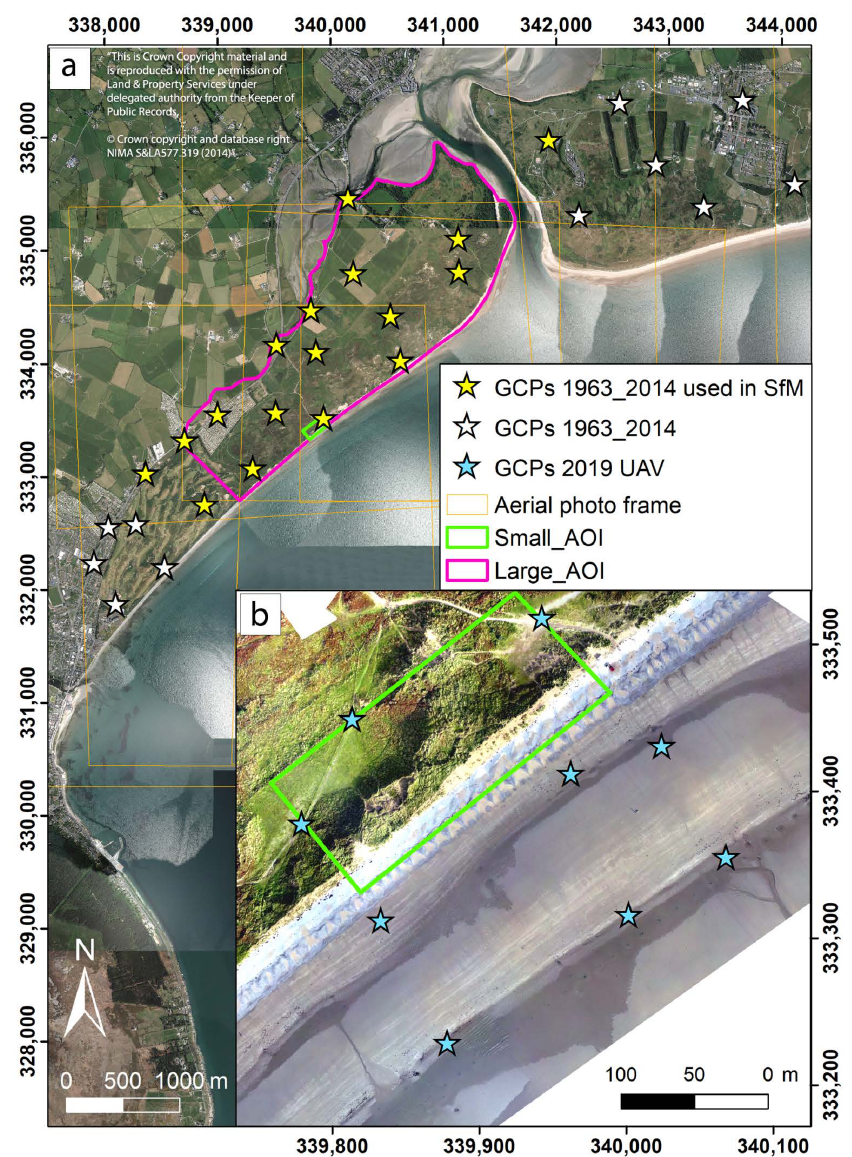
Figure 4. Ground control point (GCPs) locations for both the structure-from-motion (SfM) of 1963 aerial photographs ( a ) and 2019 unmanned aerial vehicle (UAV) datasets ( b ). ( a ) The background is the 2014 orthophoto provided by the Ordnance Survey of Northern Ireland. ( b ) The background is the orthophoto produced by the SfM process from 2019 UAV images. The graticule is in TM75/Irish Grid (transverse mercator)